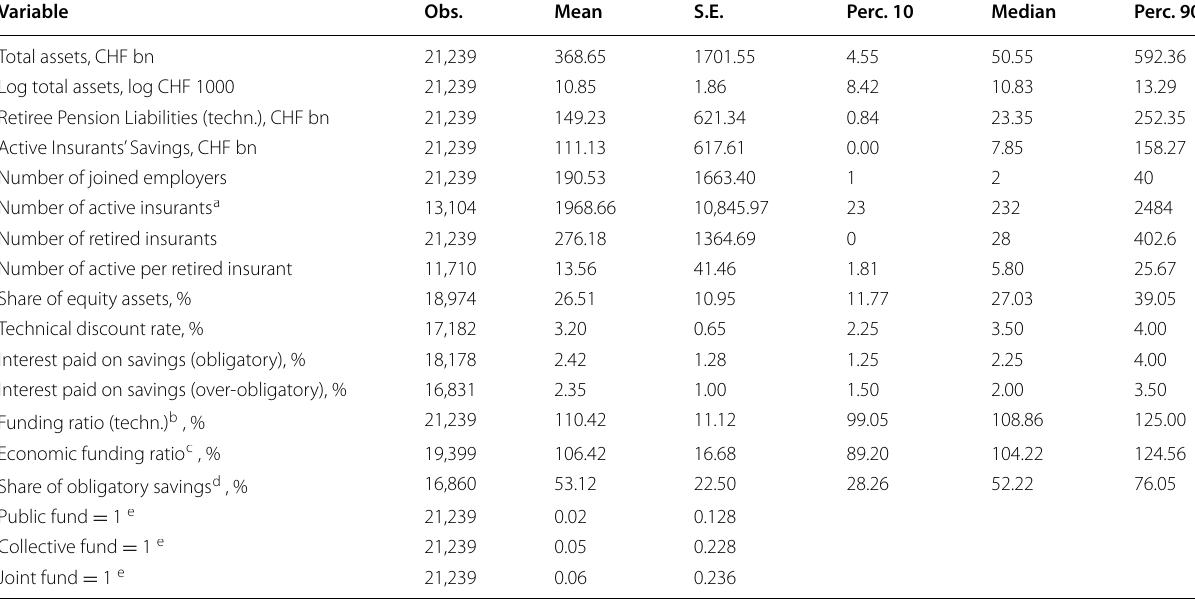
Table 1 Summary statistics of pension funds’ key